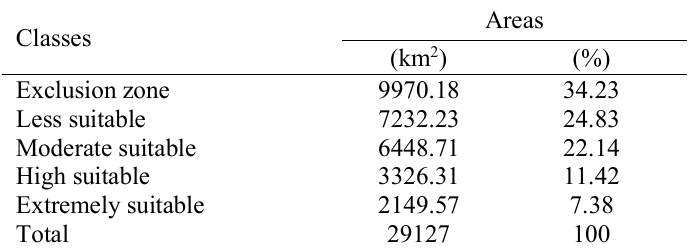
Table 6. The areas of classes of final land suitability map by fuzzy PROMETHEE